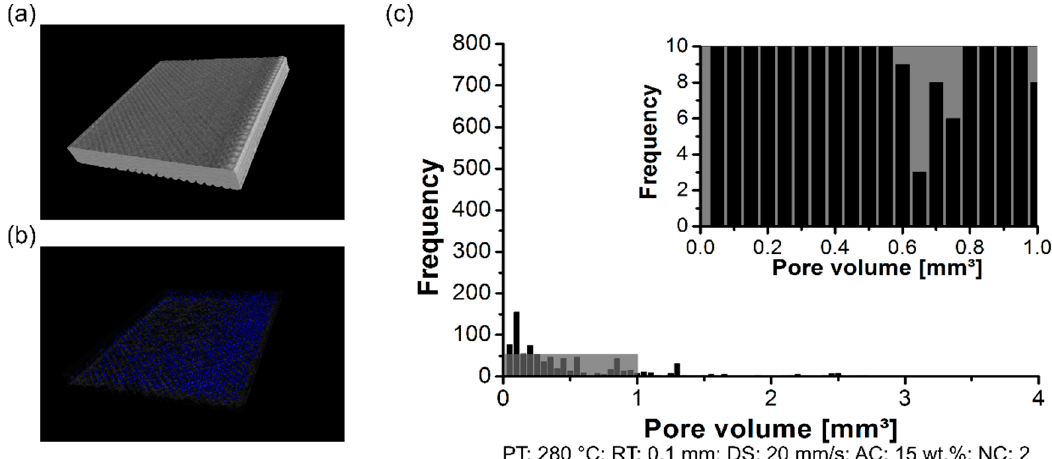
Figure 15. Pore distribution on the 3D ‐ printed ABS for condition six (PT: 280 °C, RT: 0.1 mm, DS: 20 mm/s, AC: 15 wt.%, and NC: 2): ( a ) scanned volume, ( b ) pores distribution, and ( c ) pore volume histogram.